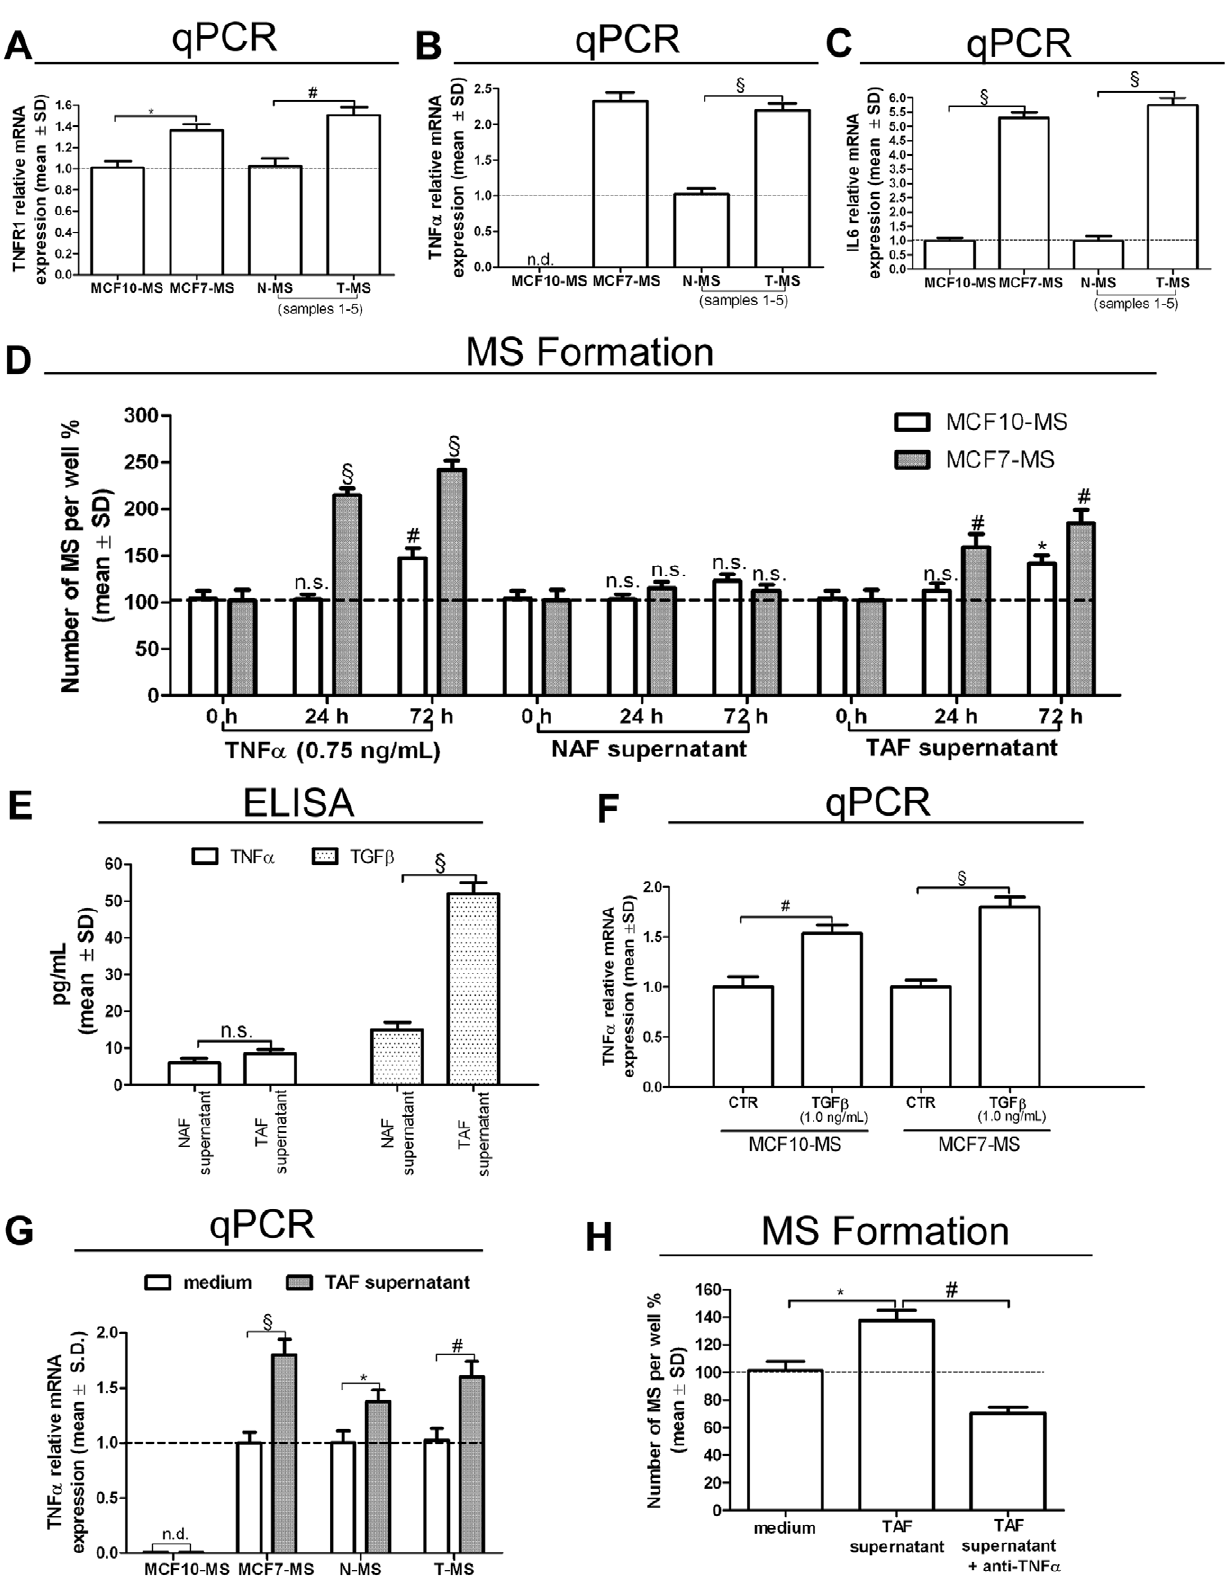
Figure 1. Autocrine TNF a loop in MS exposed to the TAF supernatant. TNFR1 (A), TNF a (B) and IL6 (C) real-time reverse transcriptase quantitative (qPCR) mRNA analysis in MCF7-MS, MCF10-MS, T-MS and N-MS (samples 1–5). (D) MS formation assay in TNF a (0.75 ng/mL), NAF and TAF supernatant (10% final concentration)-exposed MCF10 and MCF7 for 24 to 72 h; (E) TNF a and TGF b ELISA test on TAF and NAF supernatants (samples